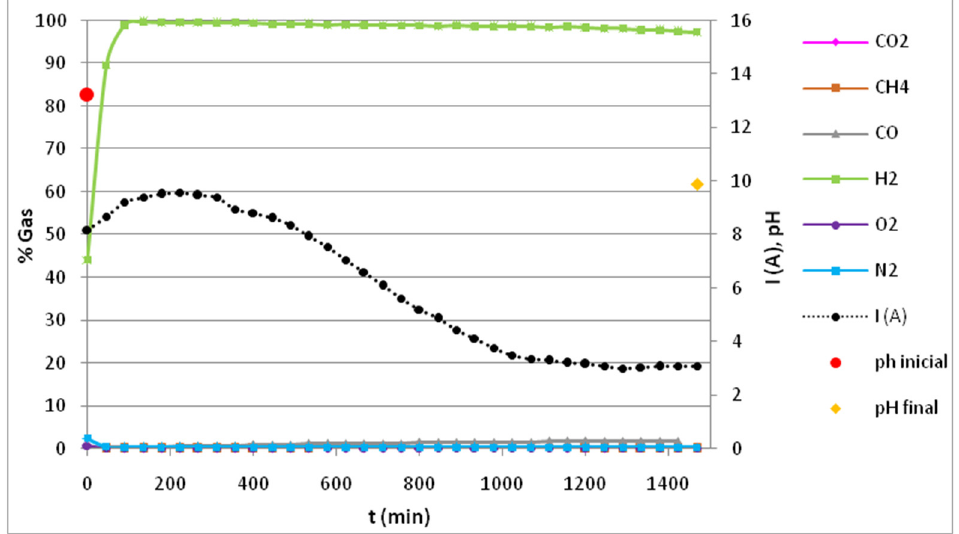
Figure 7. Temporal evolution of generated gases (%) and current in the alkaline electro-oxidation process of a glycerol solution (2.4 M and KOH 0.97 M) at a constant electrode voltage of 3.5 V.